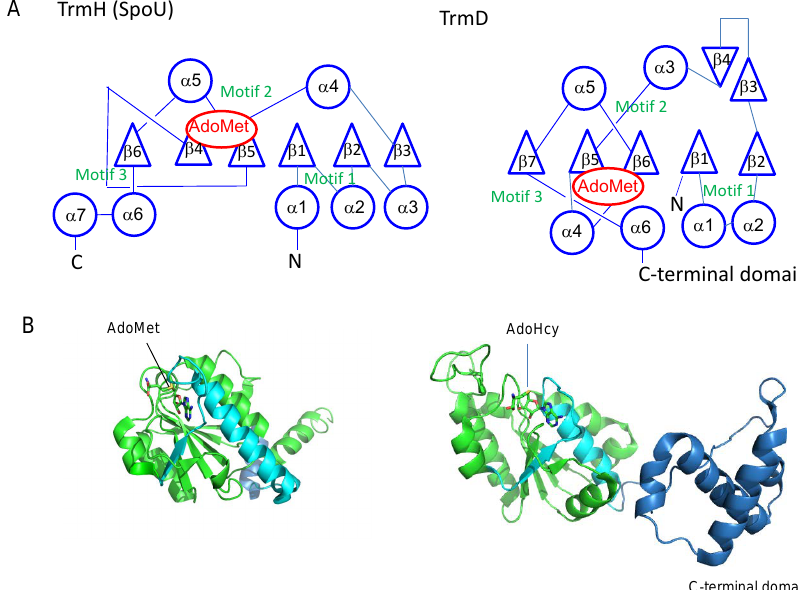
Figure 4. ( A ) Topological knot structures in TrmH (SpoU) and TrmD. The representations of topologies are in accordance with the references [10,15,19]. Circles, triangles and S -adenosyl- L -methionine (AdoMet) indicate α -helices, β -strands and AdoMet binding site, respectively. ( B ) Cartoon models of T. thermophilus TrmH (Protein Data Bank ID: 1v2x) and Escherichia coli TrmD (Protein Data Bank ID: 1p9p) subunits. To show the knot structures, the C-terminal regions of catalytic domains are colored in cyan. The C-terminal domain of E. coli TrmD is indicated in blue. The bound AdoMet and S -adenosyl- L -homocysteine (AdoHcy) are shown by stick